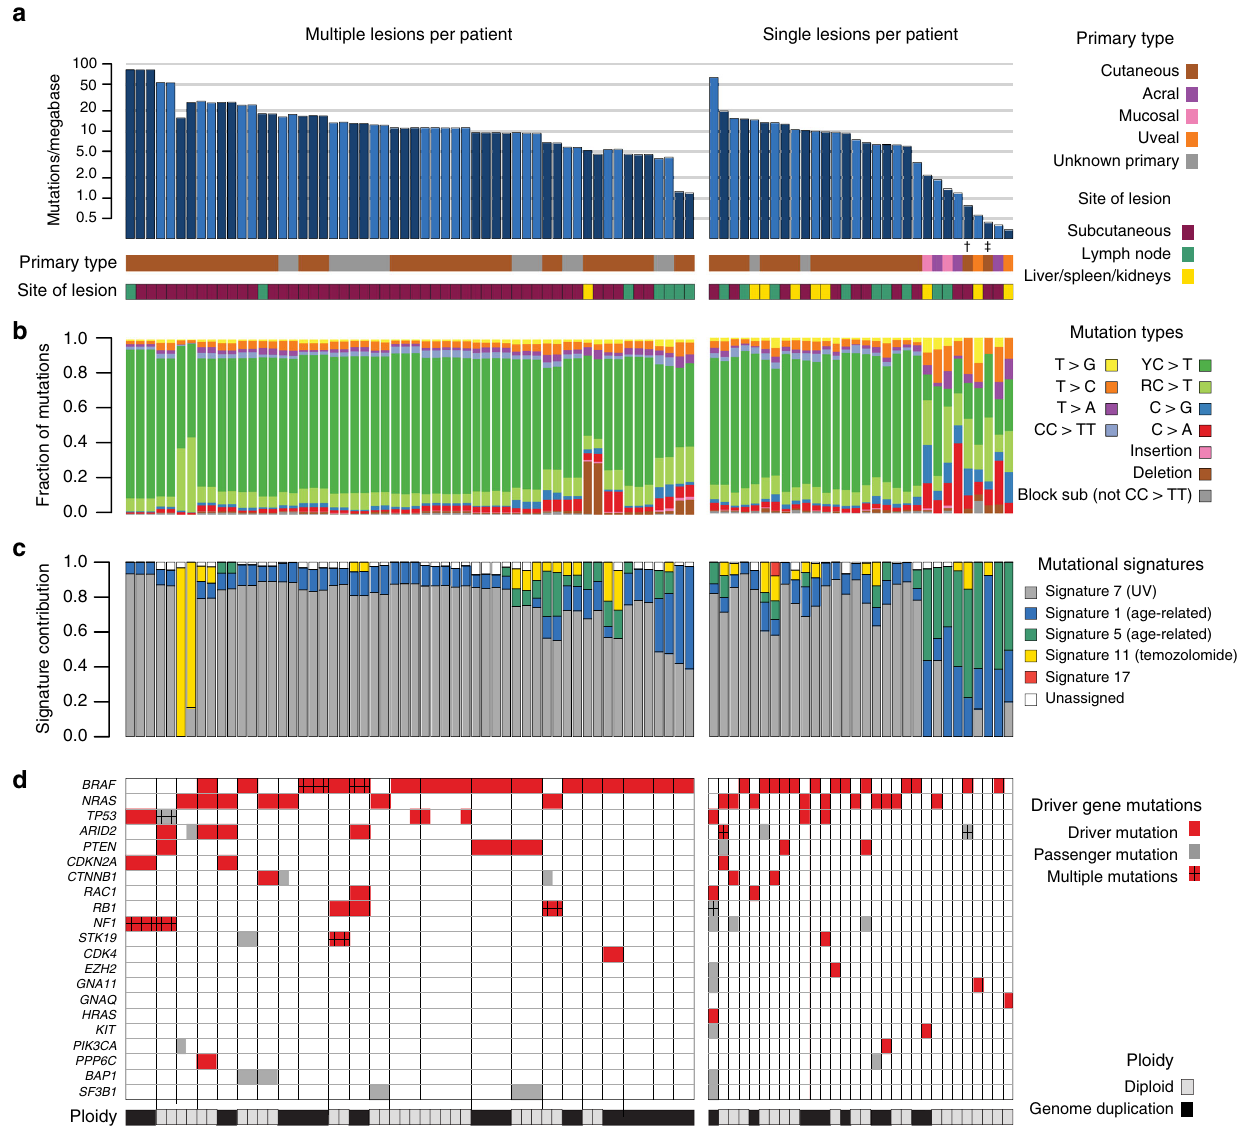
Fig. 1 Overview of mutations. a – d Left: patients from whom multiple lesions were analyzed. Right: patients from whom single lesions were sampled. Patients are ordered by the number of mutations identi fi ed per patient, and lesions are further ordered according to time of sampling. a Number of mutations per megabase in each individual sample. Samples from different patients are indicated by alternating shades of blue. † One patient had a borderline acral primary tumor situated at a toe. ‡ One patient had a perianal cutaneous primary tumor, likely not exposed to UV radiation. b Fraction of mutation types per lesion. c Estimated contribution of mutational processes by fraction of mutations explained by each mutational signature 26 , according to the classi fi cation of Alexandrov et al. 32 . Only signatures explaining >5% of mutations are shown, and only signatures 7, 1, 5, 11, and 17 were assessed. d Mutations identi fi ed per lesion in established melanoma driver genes are color-coded: red boxes indicate driver mutations and gray boxes indicate passenger mutations. Multiple mutations per gene are indicated with ” + ” . Genome duplication events are shown per sample in gray (diploid) or black (genome duplication) for each